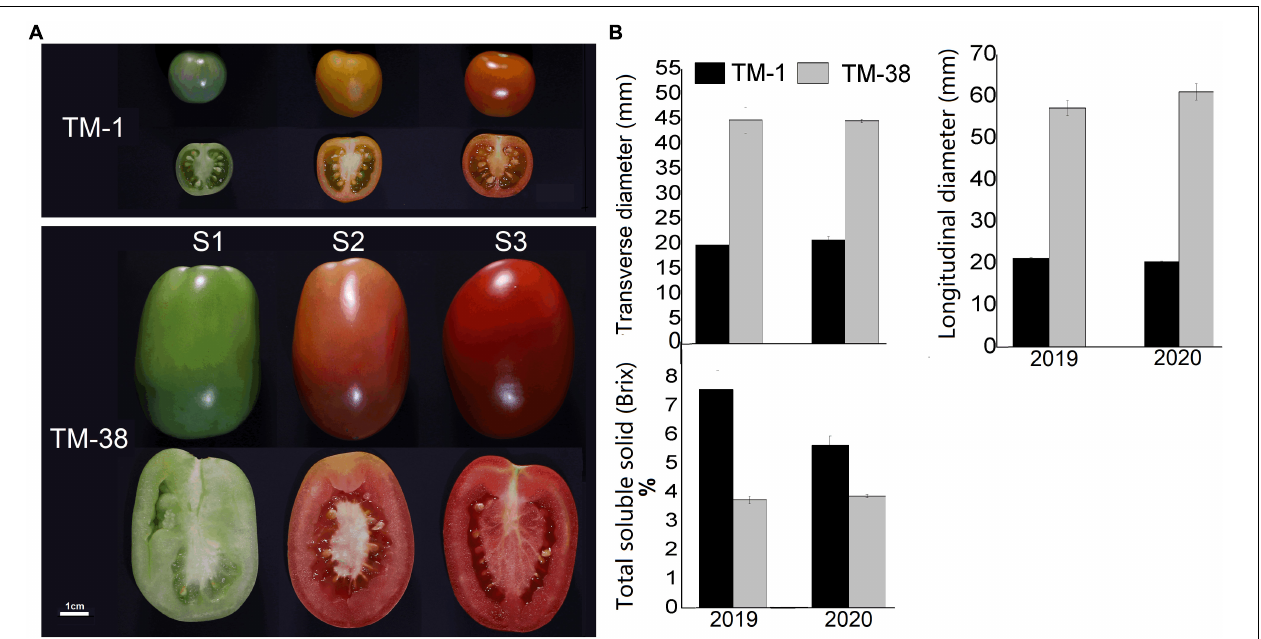
FIGURE 1 | (A) Close-up views of TM-1 ( Solanum galapagense L., LA0436) and TM-38 ( S. lycopersicum L. cultivar M82, LA3475) at green ripe (S1), turning-color (S2), and red ripe (S3) stages. (B) The changes in fruit diameters and total soluble solids (TSS) at S3. Values are means ± SE.